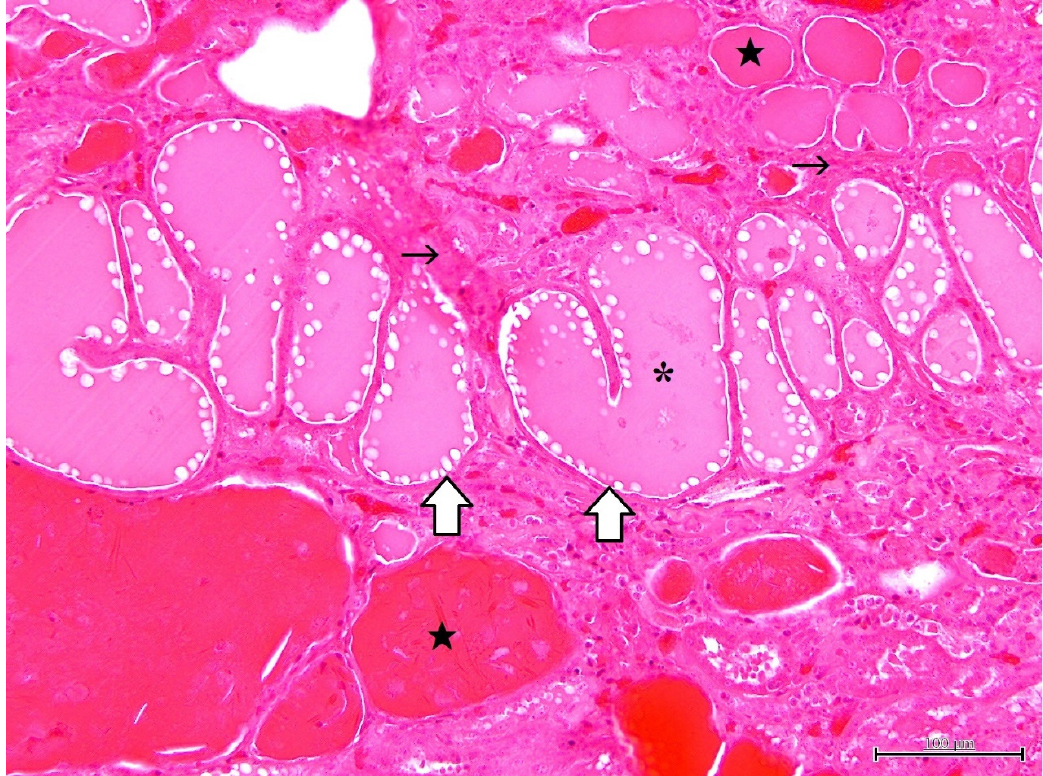
Figure 2. Microscopic finding of polycystic kidney. Note multiple cystic structures (open arrow) containing homogenous pinkish (asterisk) and/or eosinophilic (solid star) materials. Interstitial fibrosis (thin arrow) is also seen. HE stain. ×200, Bar = 100 μ m.